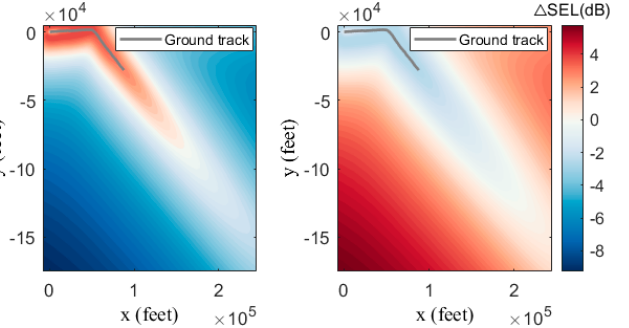
Figure 17. Effect of the atmospheric properties on the aircraft noise impact. Differences in SEL induced by a variation in temperature, as obtained for a given relative humidity ( left : AD4—AD3, right : AD6—AD5).